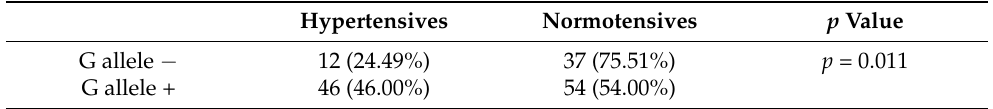
Table 5. The prevalence of arterial hypertension among patients carrying the G allele in the locus of rs2736100.